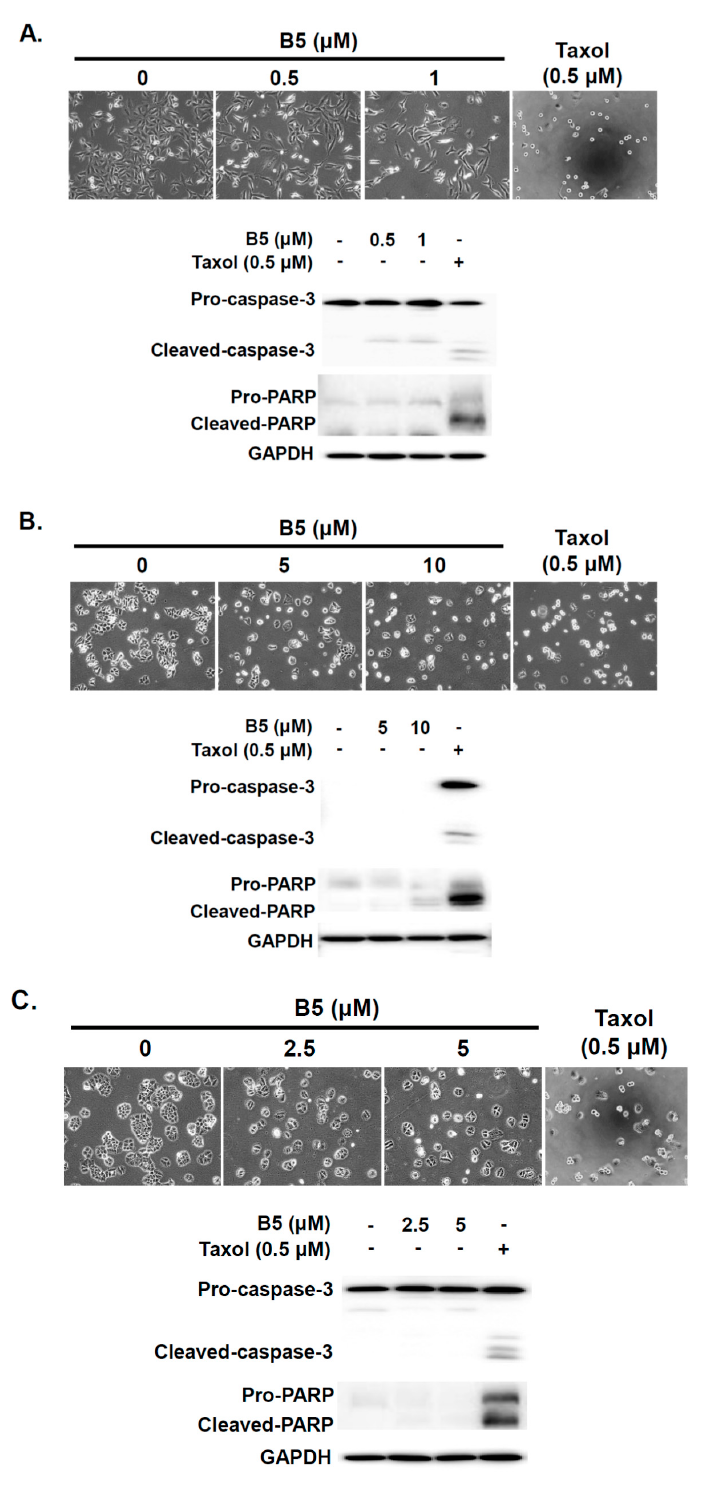
Figure 5. 9-O-farnesylberberrubine bromide modulates apoptosis in NSCLC cells. ( A ) A549, ( B ) H23, and ( C ) H1435 cells were incubated with a control medium or that containing B5; the cellular morphology was observed using optical microscopy. The total cell lysate was collected after 24 h of treatment, and the expression of caspase-3 and PARP was examined using western blot analysis. Taxol was used as a positive control. GAPDH was used as a loading control. Three independent experiments were performed, and a representative experiment was